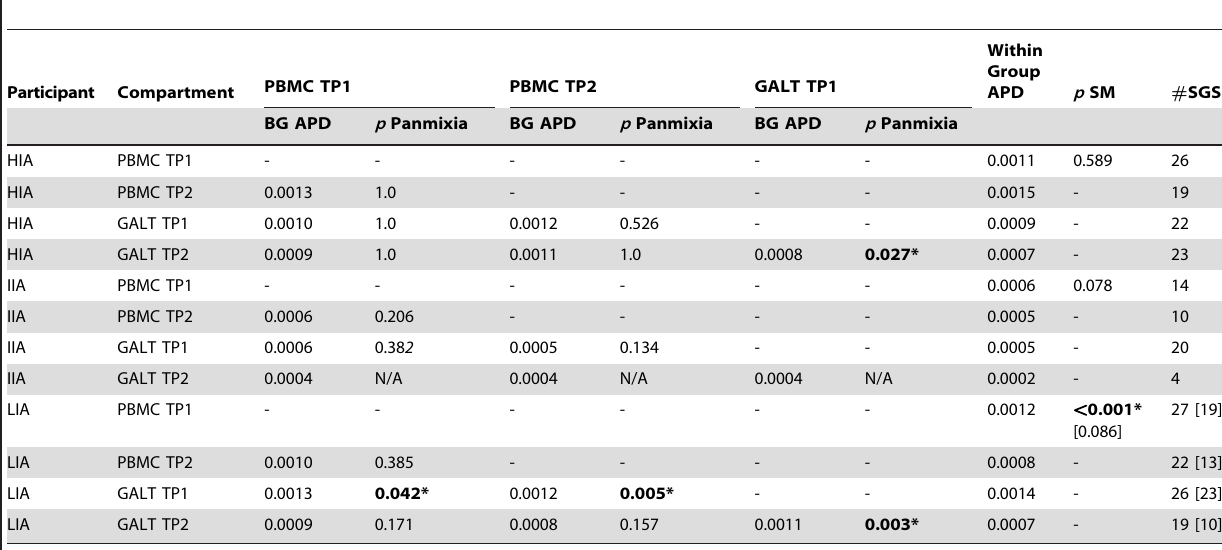
Nucleotide Distance Calculations with panmixia and Slatkin-Maddison (SM) probabilities for experimental patients (HIA, IIA and LIA) are shown. BG=Between Group, APD=Average Pairwise Distance and SM=Slatkin-Maddison Test. # SGS=number of sequences used per compartment in analysis after exclusion of hypermutated and recombinant sequences. For probability of panmixia, p -values , 0.05 are considered significant. For IIA, analysis for only one infectious variant is shown. # SGS in brackets for LIA denote number of unique sequences used in Slatkin-Maddison Test. Bracketed Slatkin-Maddison probabilities denotes p SM following removal of duplicate sequences. *=Statistically significant; N/A=Not